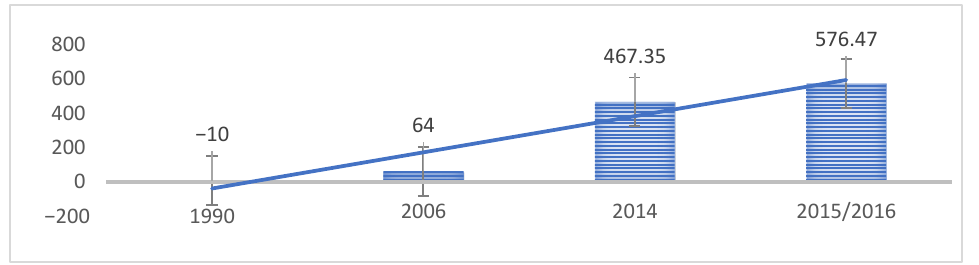
Figure 1. Evolution of the rejection of Muslims in Spain. Source: Own elaboration from Bourekba (2018, p. 19) [21].